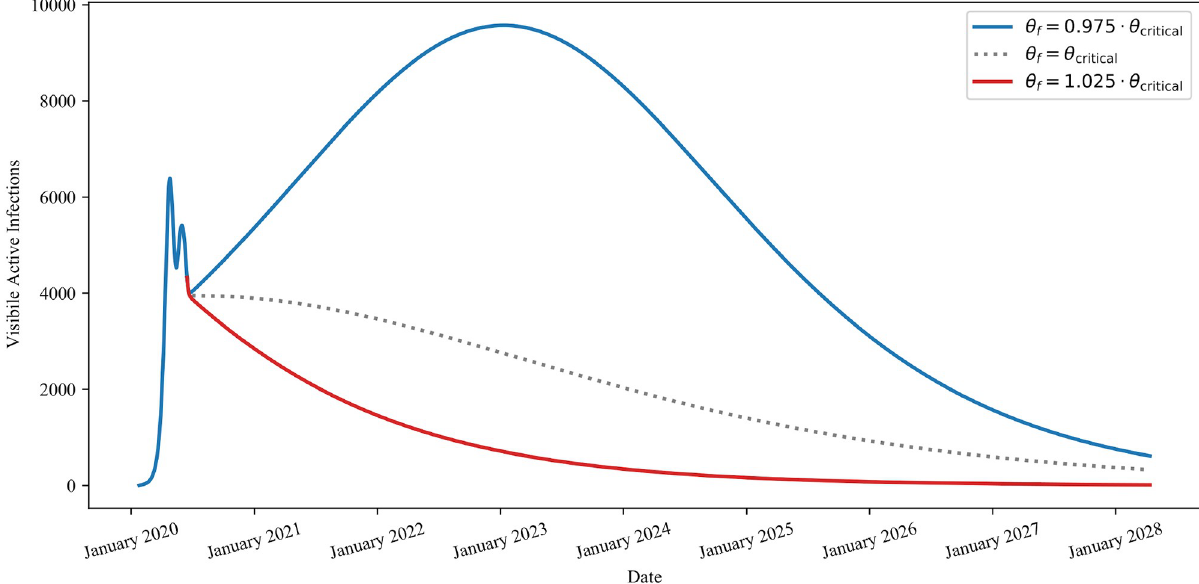
Fig 4. Behaviour of infections for θ at, above, and below θ critical . Note how all three trajectories initially decrease for t > t case where θ f > θ critical the red line decreases for all t > t c whereas in the case where θ f < θ critical the blue line initially decreases before eventually increasing again, seeding a second wave of infection. Finally, in the case where θ = θ critical the dashed line initially decreases, levels out, and then continues decreasing to